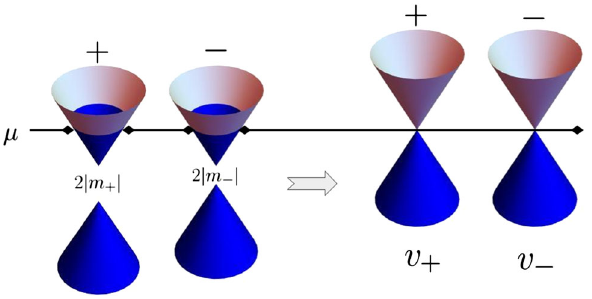
Fig. 7 Schematic description of the new Dirac cones considering charge carriers propagating near the Fermi surface, considering dif- ferent Fermi velocity for each